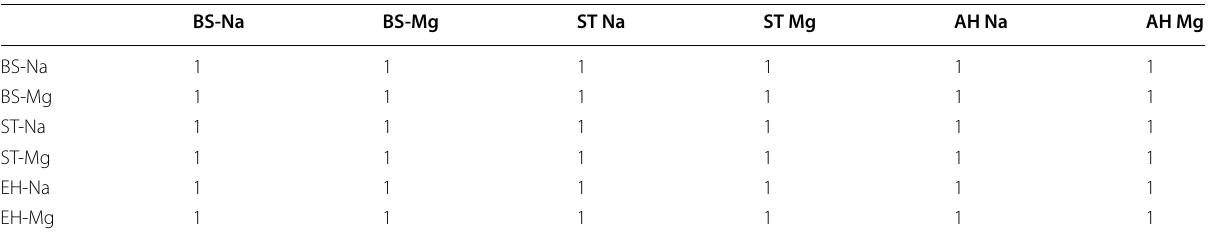
Table 7 Weight judgment matrix used for WA